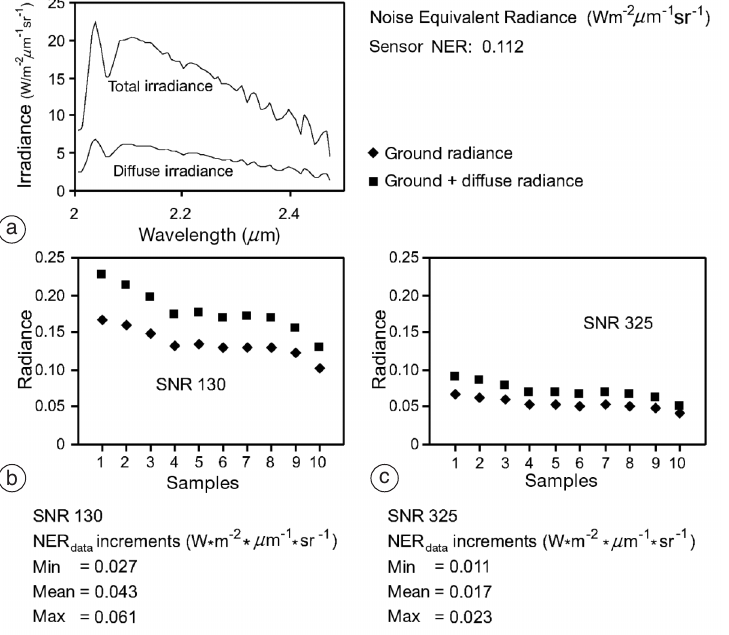
Fig. 9a-c. a) Total and diffuse atmospheric irradiance measured in the field during a MIVIS overflight on the area of fig. 1a. Diffuse irradiance contributes to NER data up to about 190% of the NER sensor . b,c) Increments of NER data (Noise Equivalent Radiance) calculated with total at sensor radiance, i.e. including the diffuse atmos- pheric component (squares) with respect to NER data calculated without diffuse atmospheric component (trian- gles), for b) SNR = 130 and c) SNR = 325. See the text for